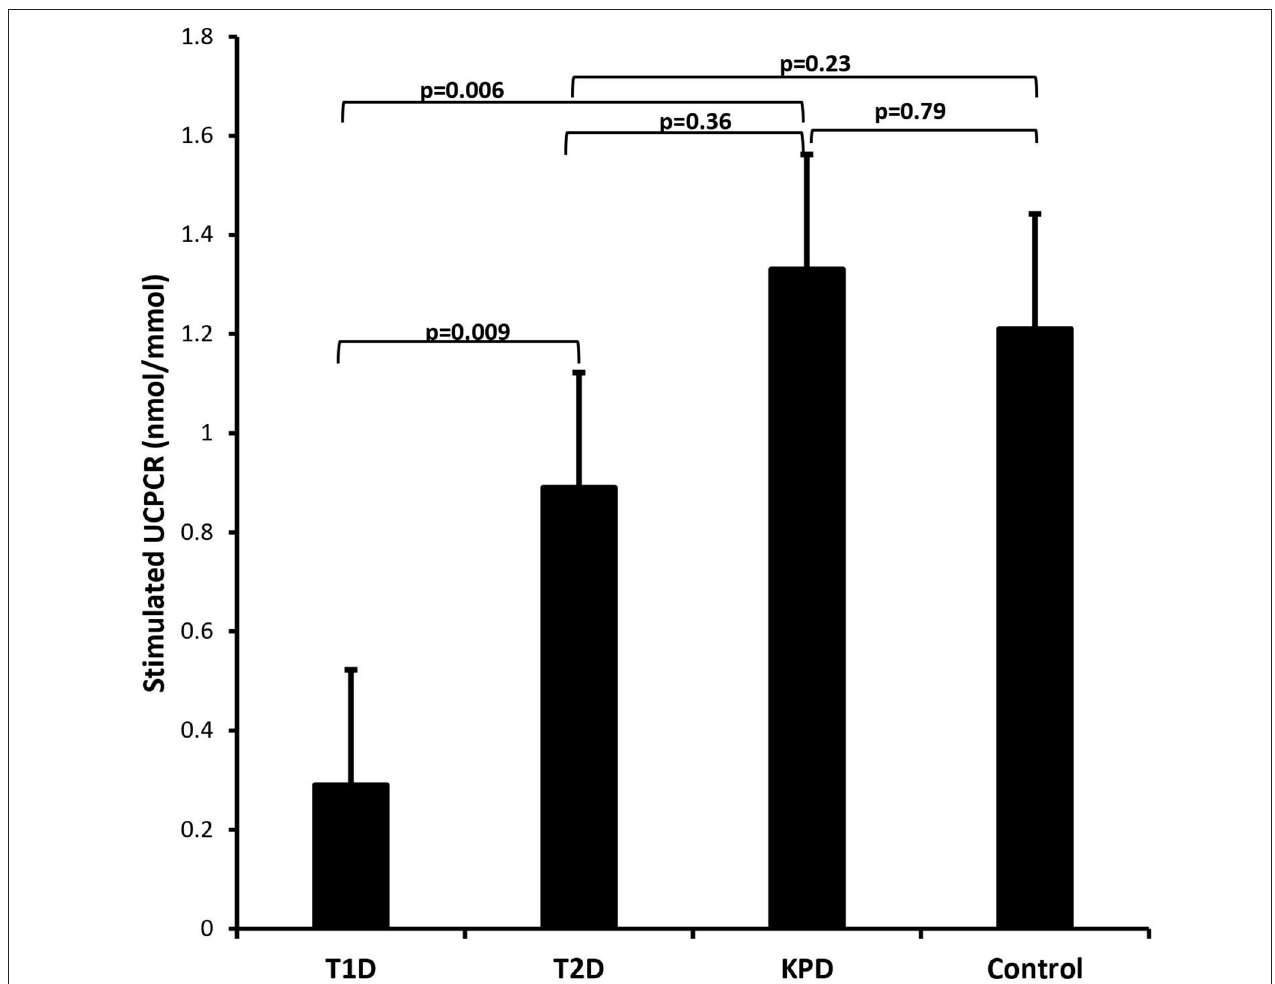
FIGURE 4 | Barchart showing that stimulated UCPCR is lowest in participants with type 1 diabetes compared to those with type 2 and ketosis-prone diabetes. The error bars represent the standard